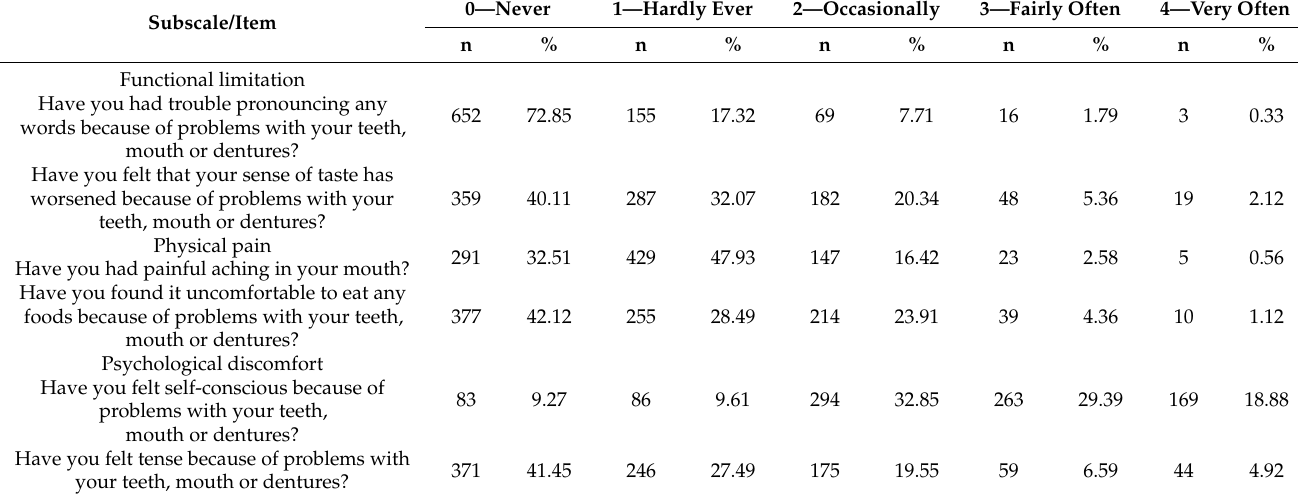
Table 2. Frequency of impact of each item of the OHIP-14 on OHRQoL among Croatian university students (n = 895).